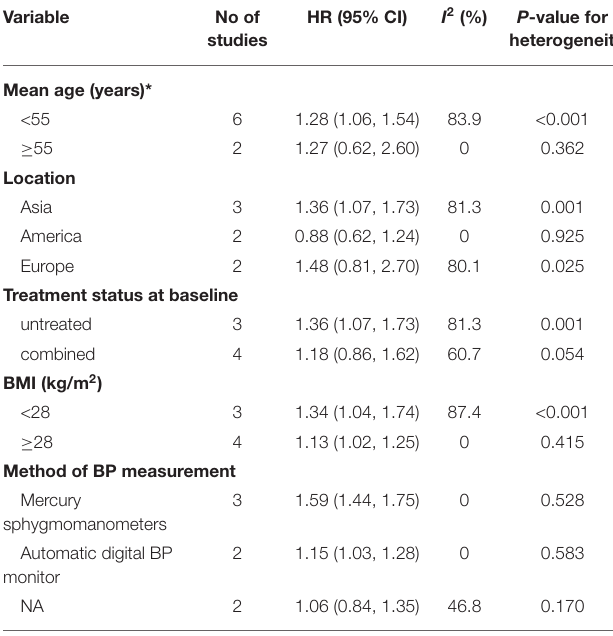
TABLE 3 | Subgroup analyses of hazard ratios for the association between isolated diastolic hypertension (IDH) and composite cardiovascular events.